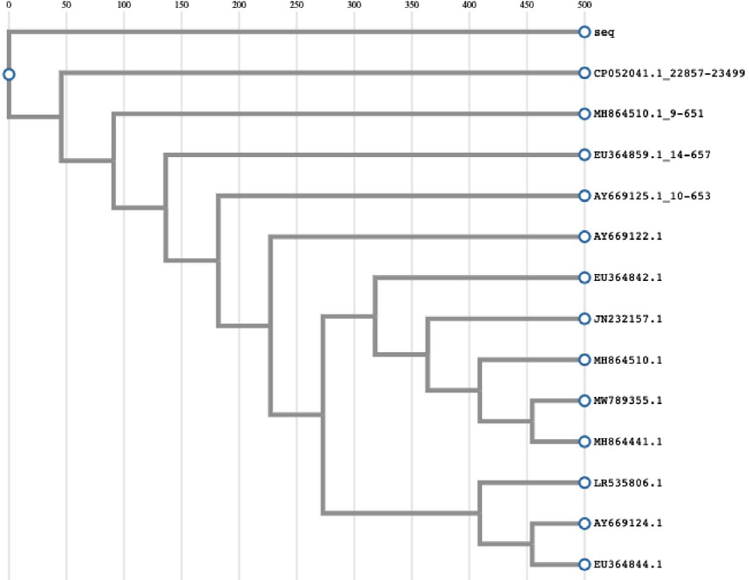
Fig. 2. Phylogeny analysis. (EU364859.1:14-657: Fusarium oxysporum strain F-X.1.7-030520-12; AY669122.1: Fusarium oxysporum strain F-W.6.2-030304; AY669125.1:10-653: Fusarium oxysporum strain F-X.1.7-030520-12; EU364842.1: Fusarium oxysporum strain F-H.6.5-030318-02; JN232157.1: Fusarium oxysporum isolate 152; LR535806.1: Fusarium oxysporum 247; EU364844.1: Fusarium oxysporum strain F-H.6.5-030318-01; CP052041.1:22857-23499: Fusarium oxysporum Fo47 chromosome IV; MH864510.1: Fusarium oxysporum strain CBS 127297; MH864441.1: Fusarium oxysporum strain CBS 127149; MH864510.1:9-651: Fusarium oxysporum strain CBS 127297; AY669124.1: Fusarium oxysporum strain F-H.6.5-030318-J1; MW789355.1: Fusarium oxysporum isolate F3-2018; EU364842.1: Fusarium oxysporum strain F-H.6.5-030318-02; JN232157.1: Fusarium oxysporum isolate 152; AY669122.1: Fusarium oxysporum strain F-W.6.2-030304; LR535806.1: Fusarium oxysporum 247; seq: the sequence for isolated